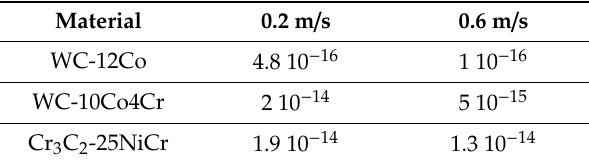
Table 4. Specific wear rate in m 2 / N vs. sliding speed for three HVOF coatings dry sliding against a counterface of the same type in a block-on-ring configuration ([17]).